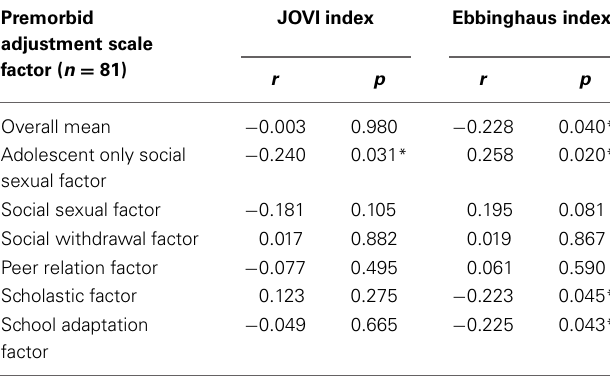
Table 4 | Spearman correlations of premorbid adjustment scale factors and perceptual organization task